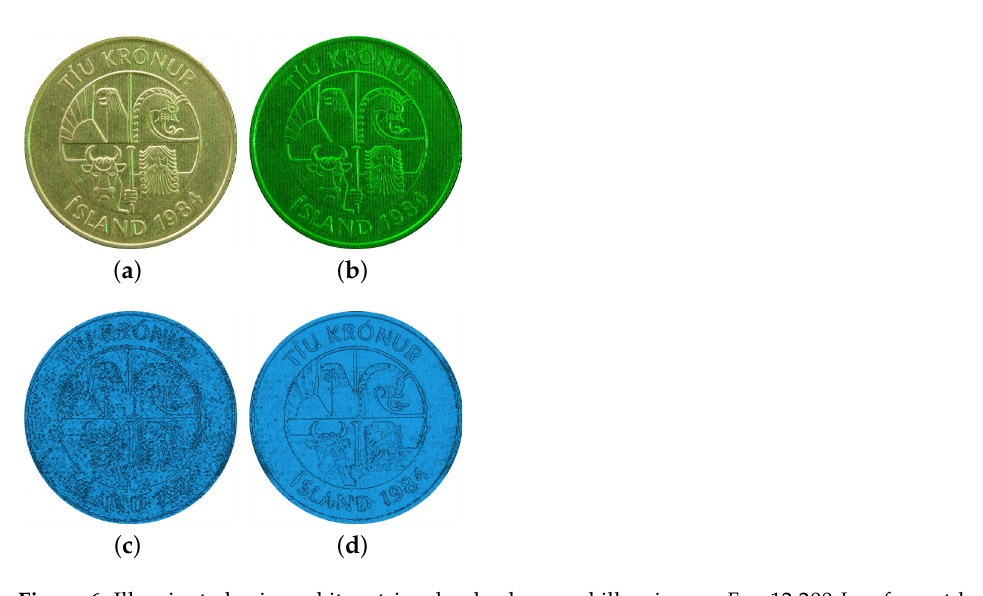
Figure 6. Illuminated coin and its retrieval as background illuminance E = 12,200 Lux for outdoor measurement. ( a ) without filtering; ( b ) with filtering; ( c ) retrieval using the image of ( a ); ( d ) retrieval using the image of ( b ).